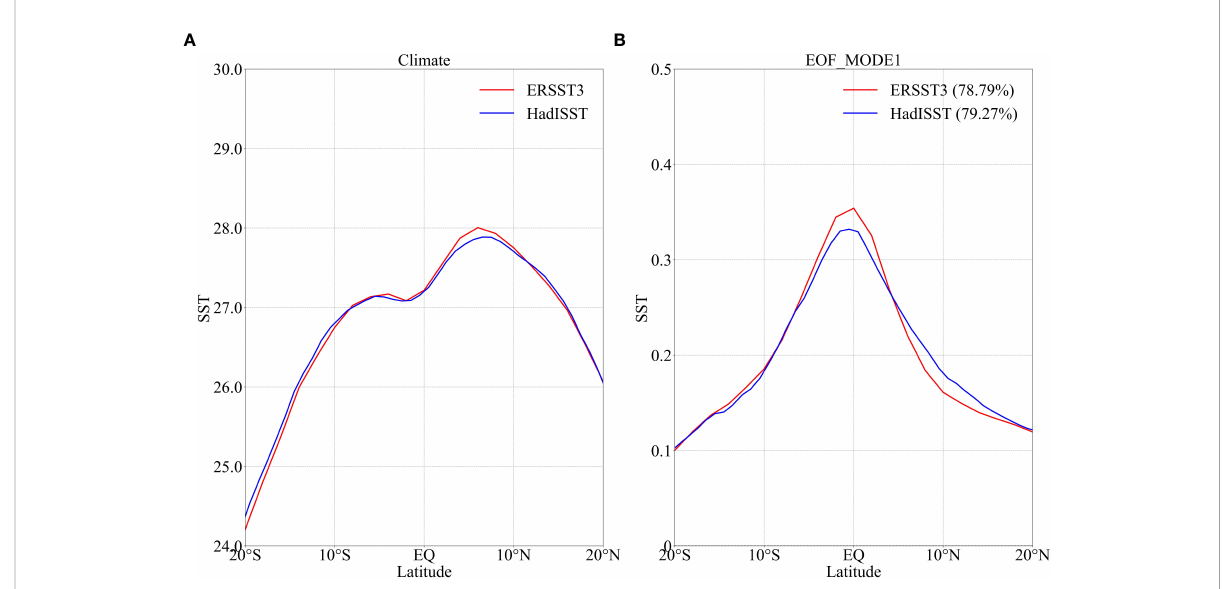
FIGURE 3 The distributions of climatological zonal-mean tropic SST (A) and Principal mode of the SST (°C) from 1948 to1978 (B) . Red and blue lines are based on the ERSST3 and HadISST,